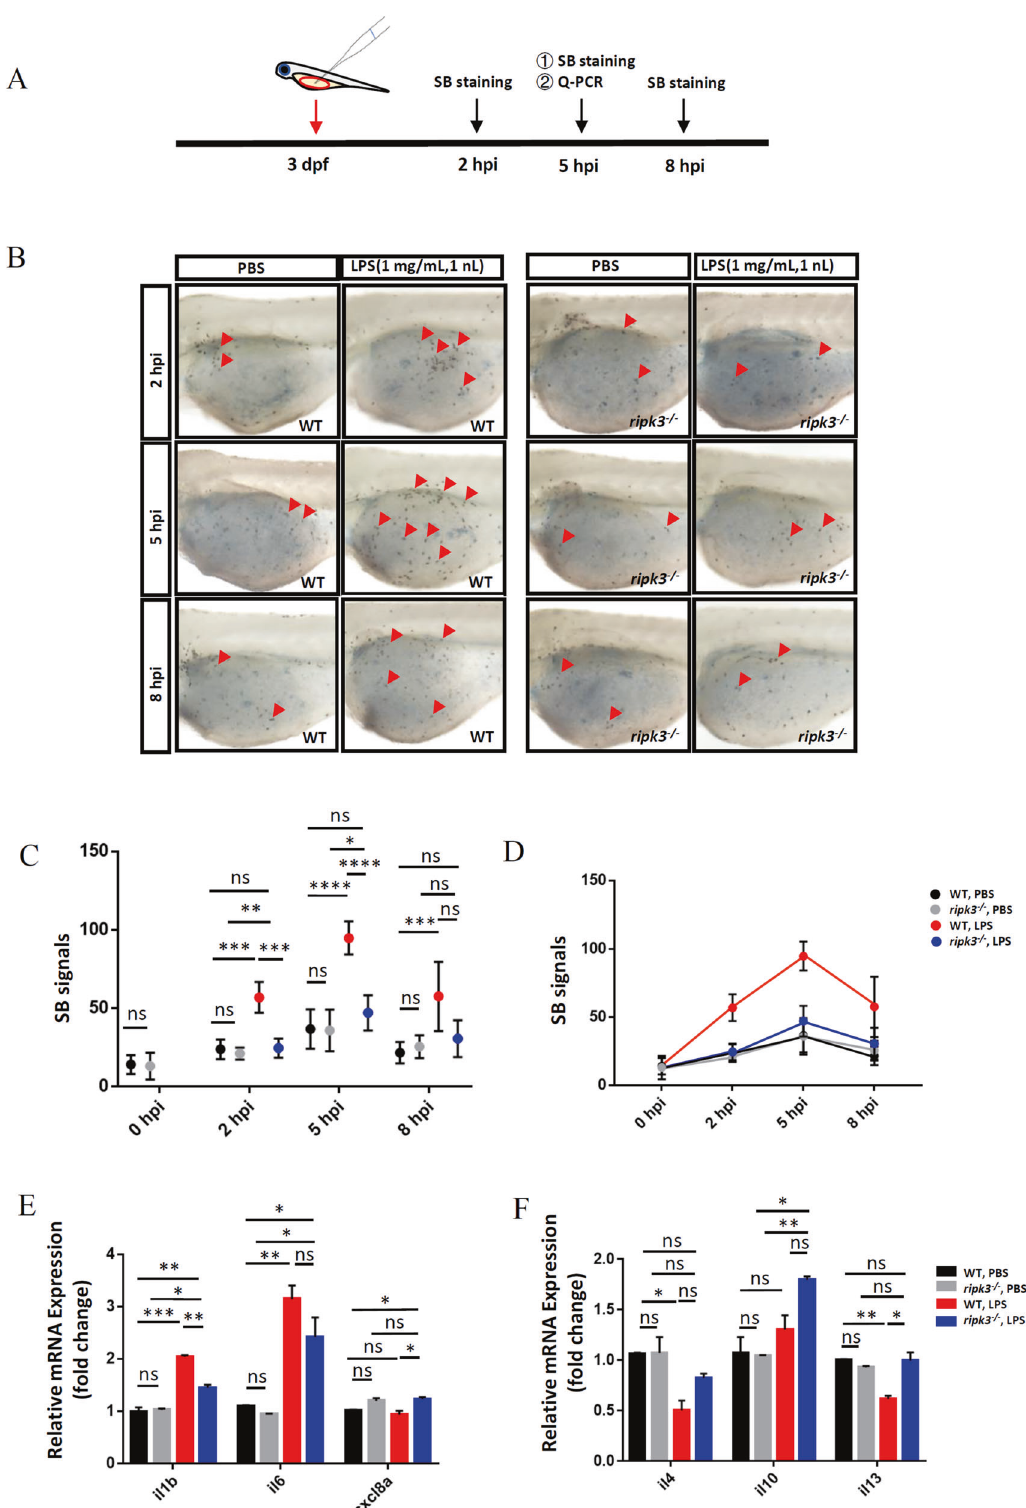
Fig. 5 De fi ciency of ripk3 attenuated the LPS-induced in fl ammatory responses. A Experimental design. The 3 dpf WT and ripk3 -de fi cient larvae were injected with LPS, and collected at 5 hpi for the detection of cytokines. The neutrophil accumulation was evaluated by SB staining at 2, 5, and 8 hpi. B Fewer neutrophils migrated to the injection sites. At 2, 5, and 8 hpi, fewer neutrophils (red arrows pointed) could be found in the yolk sac of the ripk3 -de fi cient larvae. C Quanti fi cation of ( B ) ( n ≥ 6, one-way ANOVA). D Quanti fi cation of ( B ), showing the trends of the accumulated neutrophils. E The expression levels of pro-in fl ammatory cytokines ( il1b , il6 , and cxcl8a ) at 5 hpi ( n ≥ 10, one-way ANOVA). F The expression levels of anti-in fl ammatory cytokines ( il4 , il10 , and il13 ) at 5 hpi ( n ≥ 10, one-way ANOVA).